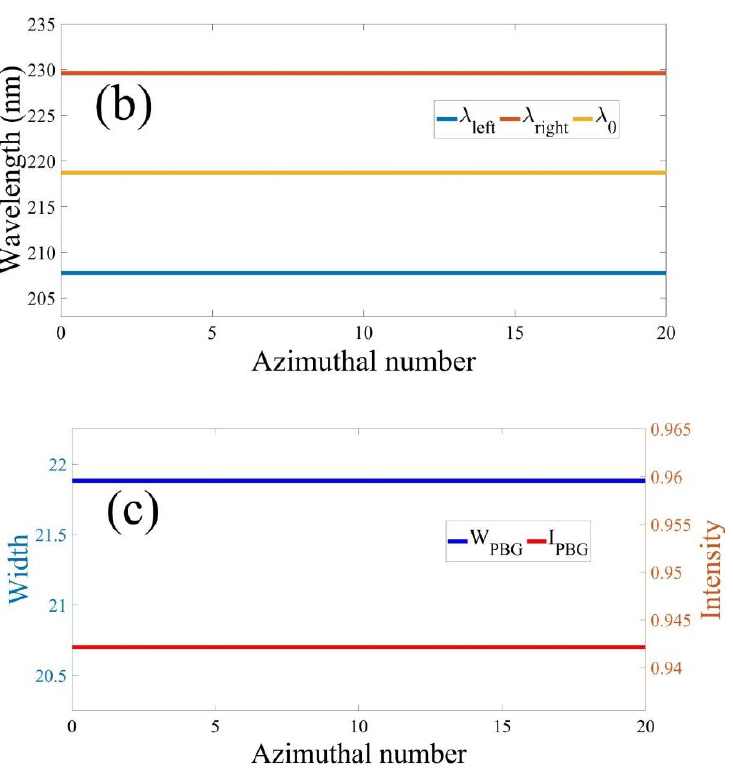
Figure 3. The effects of the azimuthal number for TE and TM polarizations on the reflectance of the proposed design ( a ), the edges and the central wavelength of the photonic bandgap (PBG) ( b ), and the average intensity 𝐼 𝑃𝐸𝐺 and the width 𝑊 𝑃𝐸𝐺 of the PBG ( c ).